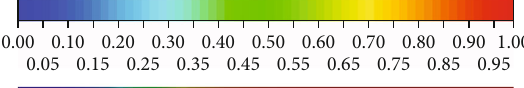
Contours of mass fraction of CH (time = 3.000 e+ 4 Contours of mass fraction of CH (time = 6.000 e+ 02) 4 (time = 9.000 e+ 02) Contours of mass fraction of CH 4 Contours of mass fraction of CH (time = 1.200 e+ 03) 4 Contours of mass fraction of CH (time = 1.500 e+ 03) 4 (time = 3.600 e+ 03) Contours of mass fraction of CH 4 Figure 6: CH concentration contours of the tunnel central 4 longitudinal